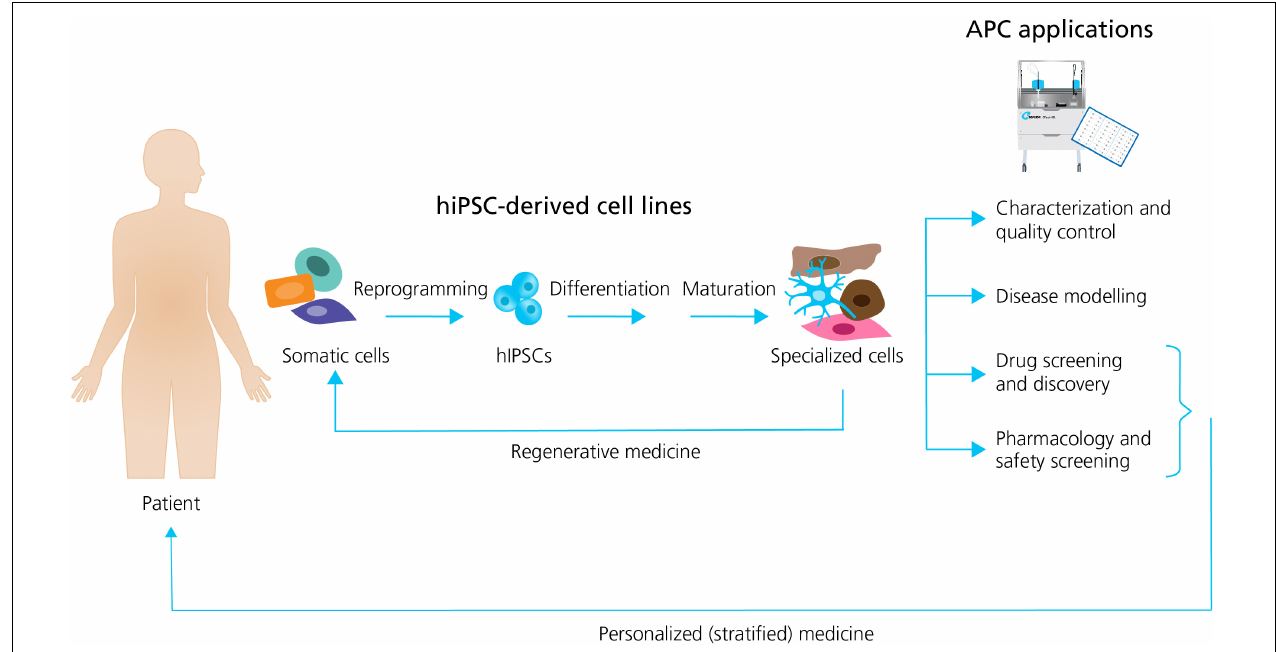
FIGURE 1 | Generation of specialized hiPSC-derived cells and APC applications. Somatic patient cells can be reprogrammed into hiPSCs, followed by the differentiation and maturation into specialized cells. The specialized cells can be used directly in regenerative medicine, or they can be employed together with APC for a range of applications including: characterization and quality control; disease modeling; drug screening and discovery; and pharmacology and safety screening. Patient hiPSCs can be used as personalized drug screening and pharmacology models in trials. Adapted from Bellin et al. (2012), with permission from publisher Springer